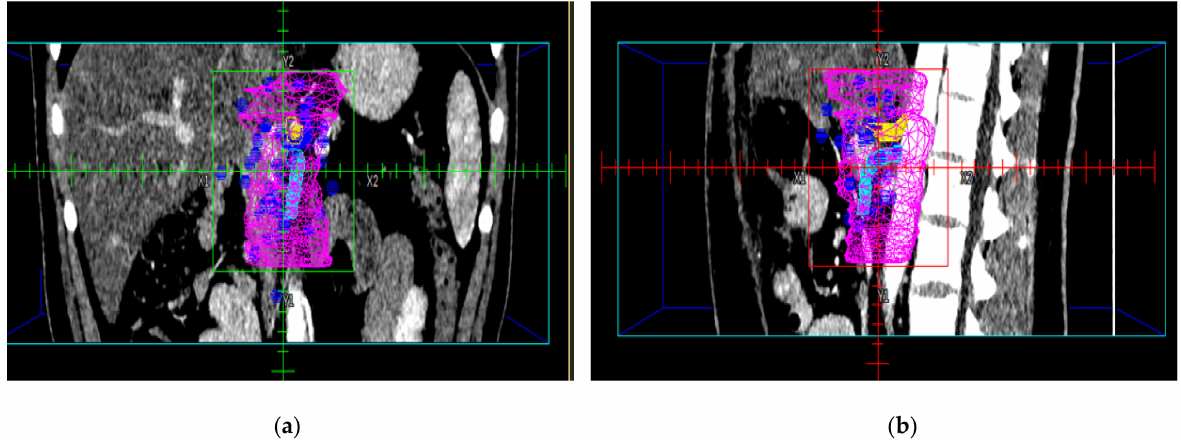
Figure 5. Iso-level recurrence maps were transferred to MIM and Pinnacle, as shown in Figure 4. Coronal ( a ) and sagittal view ( b ).